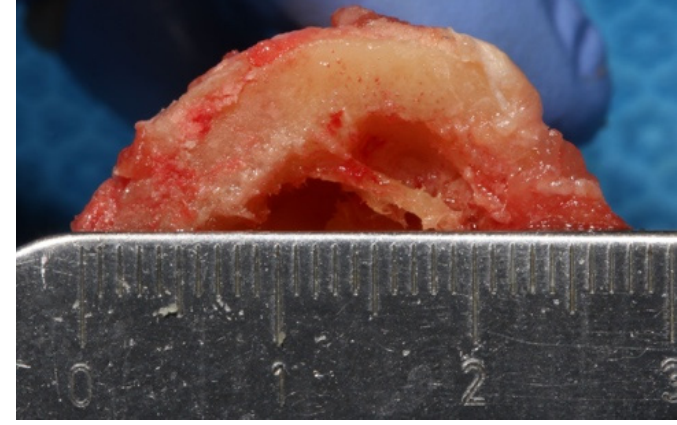
Figure 3. Six (6) mm cortical thickness of the tibiae. Four groups were included in the study: two straight (*†) and two tapered (‡ (cid:54) = ) implant drills [* Astra Tech, Dentsply ® , York, PA, USA † Premium, Sweden & Martina ® , Due Carrare, Italy ‡ Nobel Biocare ® , Klote, Switzerland (cid:54) = Shelta, Sweden & Martina ® , Due Carrare, Italy (Figure 4a–d)].